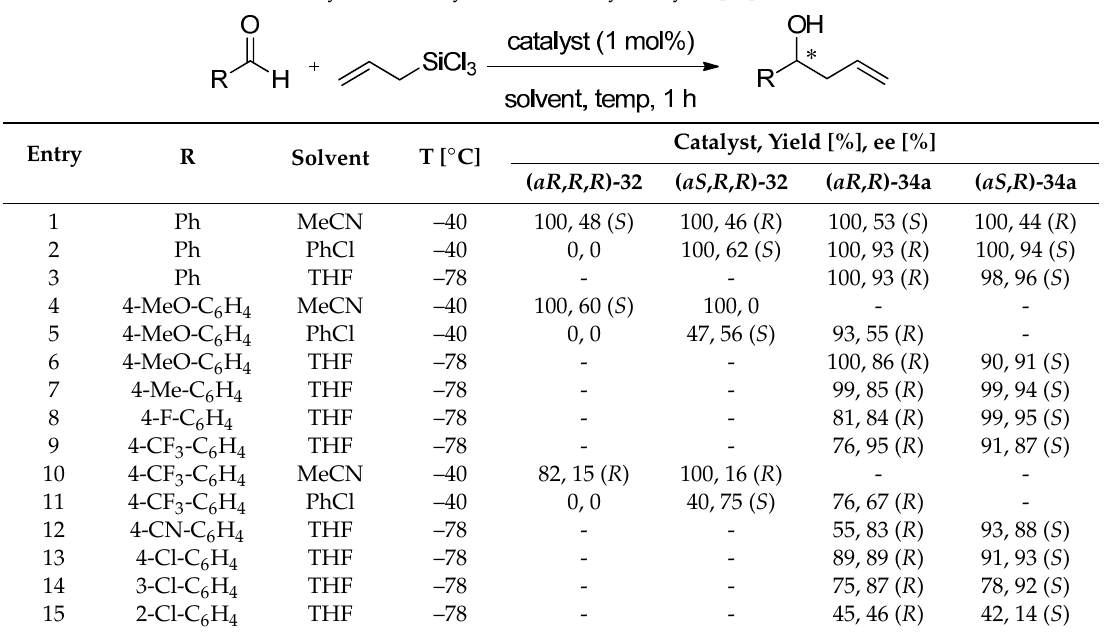
Molecules 2019 , 24 , x